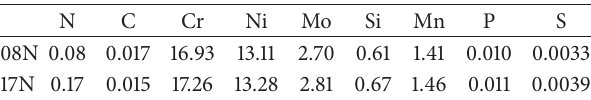
Table 1: Compositions of 316LN stainless steel (wt.%). N C Cr Ni Mo Si Mn P S 08N 0.08 0.017 16.93 13.11 2.70 0.61 1.41 0.010 0.0033 17N 0.17 0.015 17.26 13.28 2.81 0.67 1.46 0.011